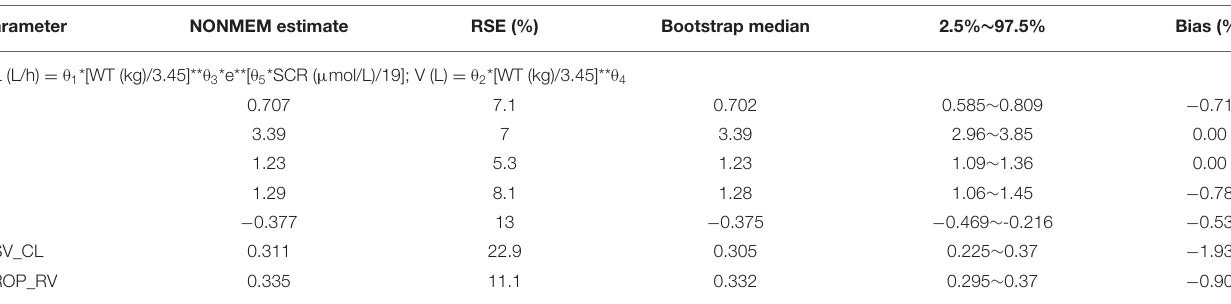
TABLE 7 | NONMEN estimates and bootstrap analysis of Model